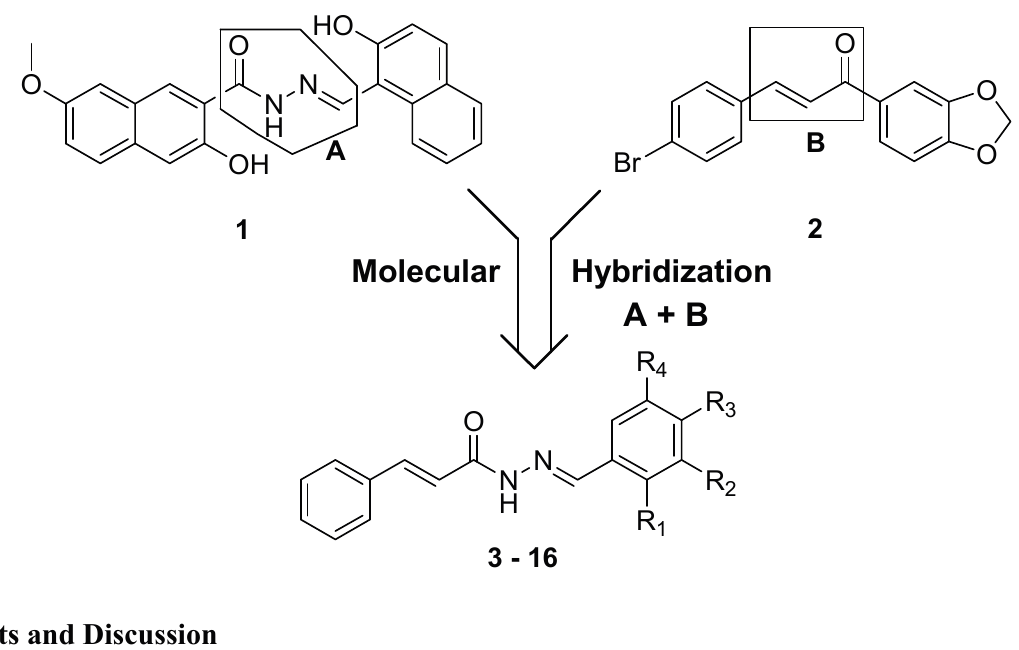
Figure 1. Design concept of cinnamic N -acylhydrazone derivatives ( 3 – 16 ).